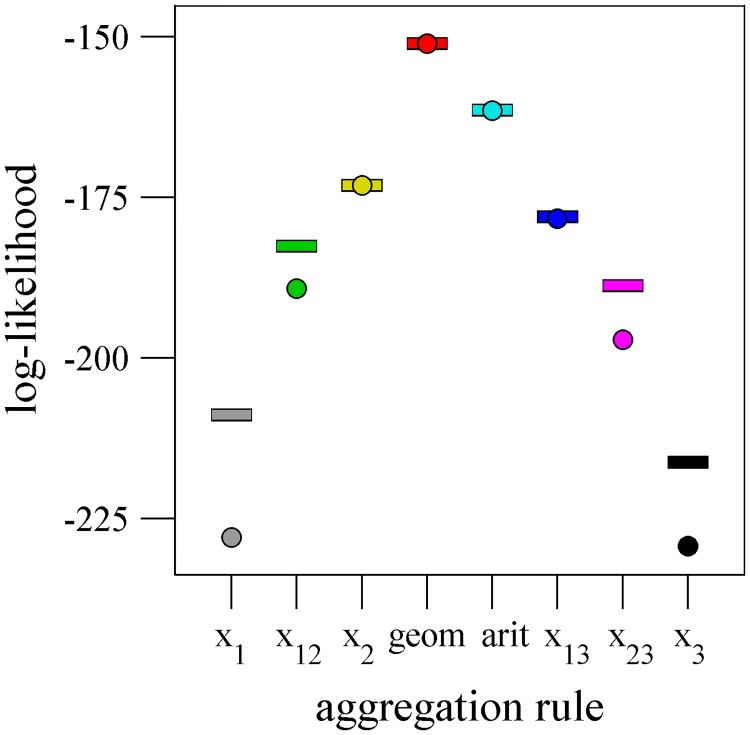
Fits of different aggregation rules to the observed group consensus estimates in Experiment 1.Observed log-likelihoods of eight different rules for aggregating initial estimates (circles) are plotted with the log-likelihoods when the noise (dashes) added to each estimation maximizes the log-likelihood (S4 Fig, S1 Methods). For the median (x2), geometric (geom) and arithmetic (arit) means, and mean of the lowest and highest estimates in each group (x13), the fits to the data are close to maximal. The other rules tested are: the lowest estimate (x1), mean of the lowest and median estimate (x12), mean of median and highest estimate (x23), and highest estimate (x3). The strategies are sorted in the x axis in an order that results in increasing values for many of the groups.